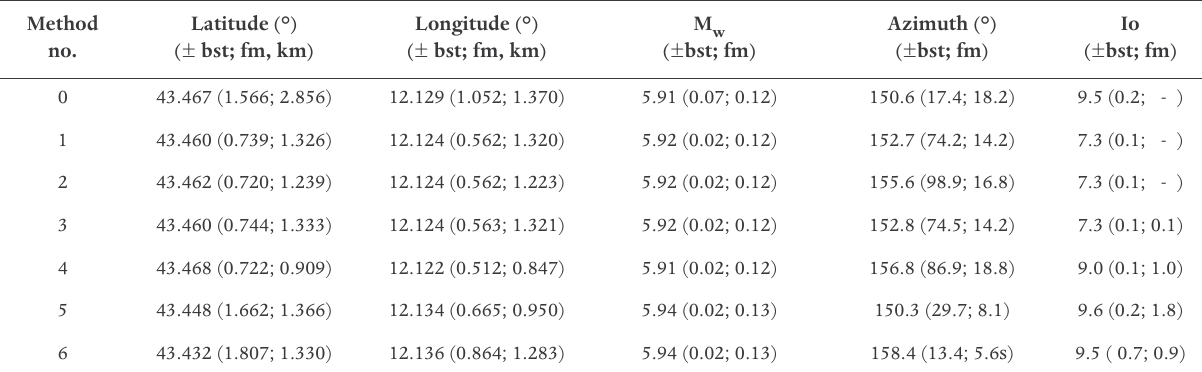
Table 2. Macroseismic parameters obtained from the intensity dataset using different methods supplied by Boxer, with associated bootstrap (bst) and formal (frm) uncertainties at 90% confidence level [Gasperini et al. 2010].